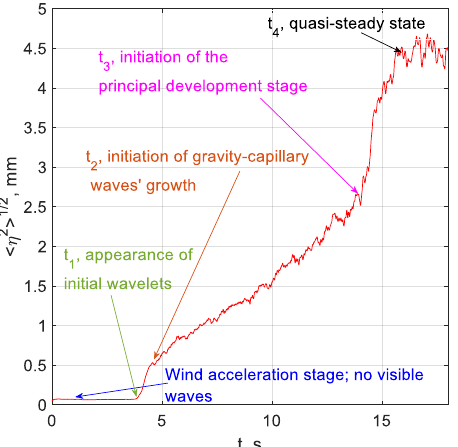
Figure 26. Definition of characteristic transition times based on slope changes in the plot of variation of the ensemble-averaged root mean square (RMS) value of the surface elevation with time ( x = 340 cm; U = 7.5 m/s).